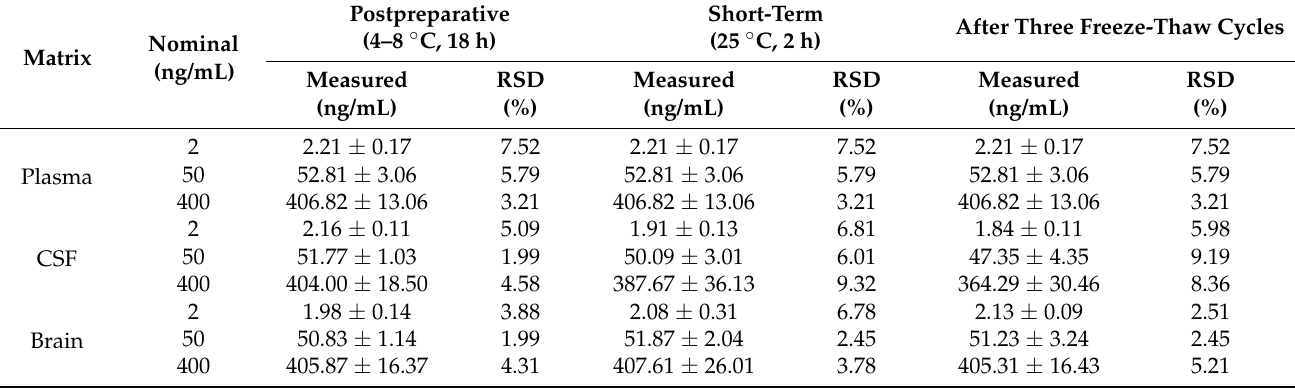
Figure 3. Representative MRM chromatograms of 5-CQA and GA in rat plasma, CSF, and brain samples. ( A1 ) Blank rat plasma sample without 5-CQA; ( B1 ) blank rat plasma sample without GA; ( C1 ) blank rat plasma sample with 500 ng/mL 5-CQA and 1000 ng/mL GA; ( D1 ) rat plasma sample collected at 5 min after tail vein injection of 50 mg/kg 5-CQA; ( A2 ) blank rat CSF sample without 5-CQA; ( B2 ) blank rat CSF sample without GA; ( C2 ) blank rat CSF sample with 500 ng/mL 5-CQA and 1000 ng/mL GA; ( D2 ) rat CSF sample collected at 5 min after tail vein injection of 50 mg/kg 5-CQA; ( A3 ) blank rat brain homogenate sample without 5-CQA; ( B3 ) blank rat brain homogenate sample without GA; ( C3 ) blank rat brain homogenate sample with 500 ng/mL 5-CQA and 1000 ng/mL GA; ( D3 ) rat brain homogenate sample collected at 5 min after tail vein injection of 50 mg/kg 5-CQA. Table 3. Stability of 5-CQA in the plasma, CSF, and brain homogenate samples of rats ( n =